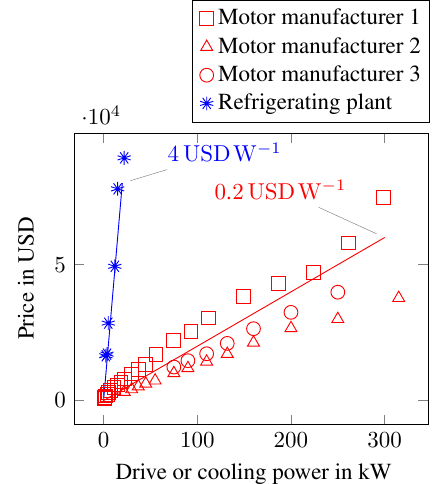
Figure 3. Pricing as of 2017 for asynchronous motors from different manufactures and for CO 2 refrigerating plants before tax and tolls. (cid:16) (cid:17) 3 1 = · 1 . 38kgm − 3 · · 0 . 25m 40ms − 1 2